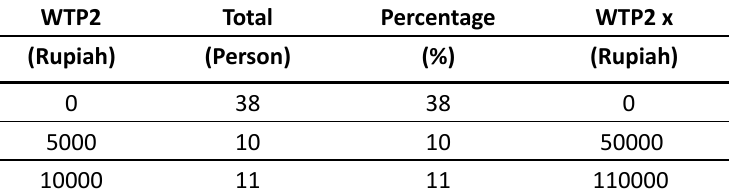
Table 6: Distribution of WTP Value on Scenario